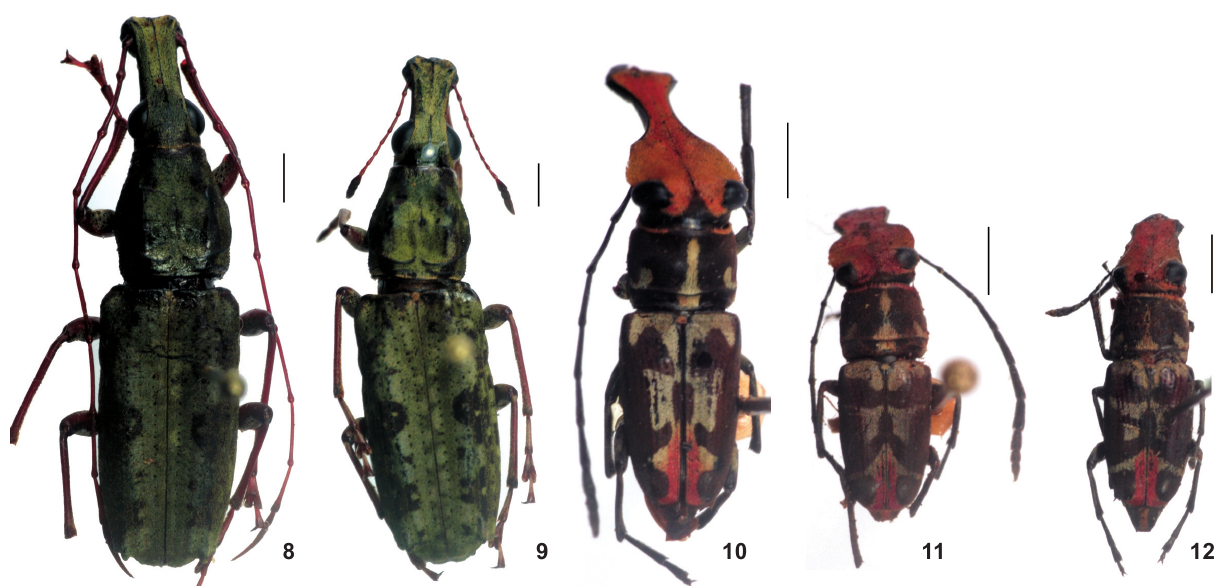
Figures 8-12. Dorsal habitus. (8-9) Hypselotropis prasinata : (8) male; (9) female. (10-12) Systaltocerus platyrhynus: (10) major male; (11) minor male; (12) female. Scale bar = 2